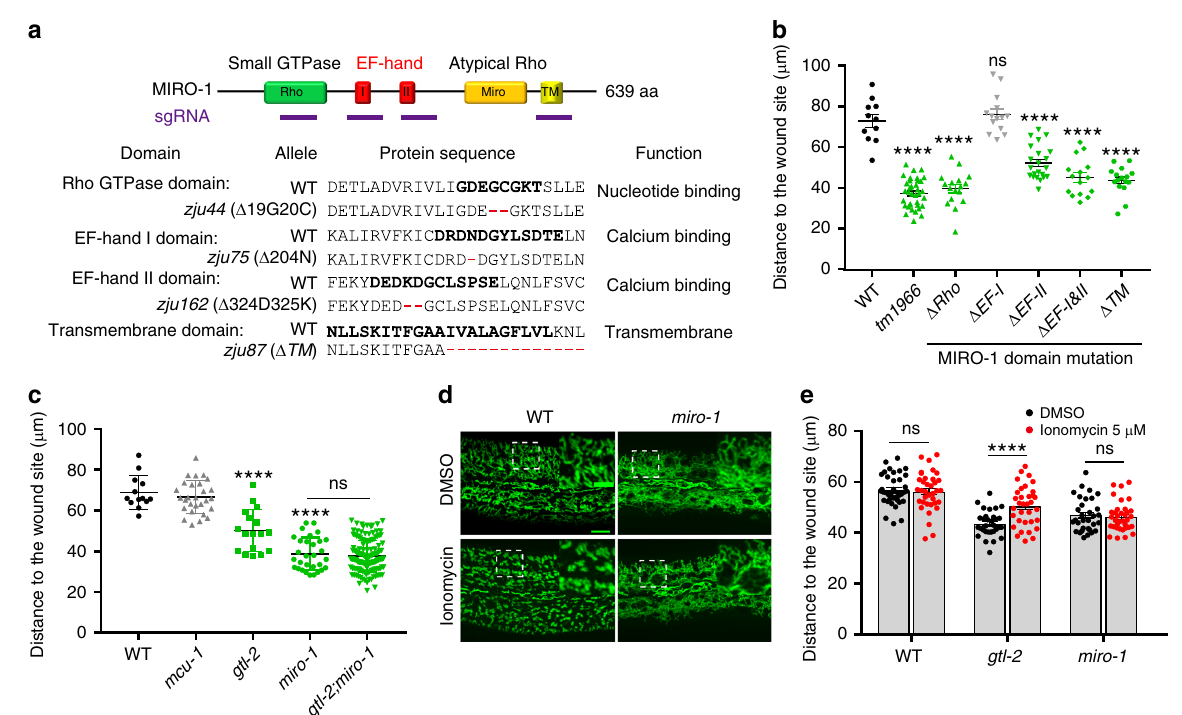
Fig. 4 WIMF is dependent on wound-induced Ca 2 + -MIRO-1 signaling. a Top, experimental design to disrupt the function of MIRO-1 protein domains using CRISPR-Cas9 mediated mutagenesis. Bottom, miro-1 in-frame mutation alleles. Sequences in bold are key residues in each domain 40 . Details of indel mutations are in Supplementary Table 5. b Quantitation of the distance of the fragmented mitochondria to the injury site shown on the left in different animals (WT, n = 11; tm1966 , n = 30; Δ Rho , n = 19; Δ EF-I , n = 14; Δ EF-II , n = 22; Δ EF-I&II , n = 15; Δ TM , n = 16 animals). Note, mutations of the Rho, EF-hand II and TM domains show reduced spreading of WIMF compared to the WT and similar to miro-1(tm1966) animal, indicating that these mutations affect MIRO-1 ’ s function. Bars indicate mean ± SEM. ns, P = 0.8321, **** P < 0.0001 (versus WT), One-way ANOVA Dunnett ’ s test. c Quantitation of the distance of the fragmented mitochondria to the injury site in TRPM/gtl-2(n2618), mcu-1(ju1154) , and gtl-2(n2618);miro-1(zju19) mutant (WT, n = 13; gtl-2 , n = 17; miro-1 , n = 36; gtl-2;miro-1 , n = 143 animals). miro-1(zju19) and miro-1(zju40) frameshift mutations were generated by CRISPR-Cas9 mediated mutagenesis in gtl-2 background. Bars indicate mean ± SEM. ns, P = 0.9558 (versus miro-1 ), two-tailed unpaired t -test; ns, P = 0.9558, **** P < 0.0001 (versus WT), One-way ANOVA Dunnett ’ s test. d Representative confocal image of mitochondrial morphology after treatment with Ca 2 + ionophore ionomycin in both WT and miro-1 mutants. Scale bars, 10 μ m, and 5 μ m (zoom-in). N = 3 independent experiments. e Quantitation of the distance of the fragmented mitochondria to the injury site in gtl-2(n2618), miro-1(tm1966) mutant treated with low concentration of ionomycin (2.5 μΜ treated for 1 h) (WT-DMSO, n = 37; WT-ionomycin, n = 36; gtl-2 -DMSO, n = 31; gtl-2 -ionomycin, n = 34; miro-1 -DMSO, n = 32; miro-1 -ionomycin, n = 35). Bars indicate mean ±